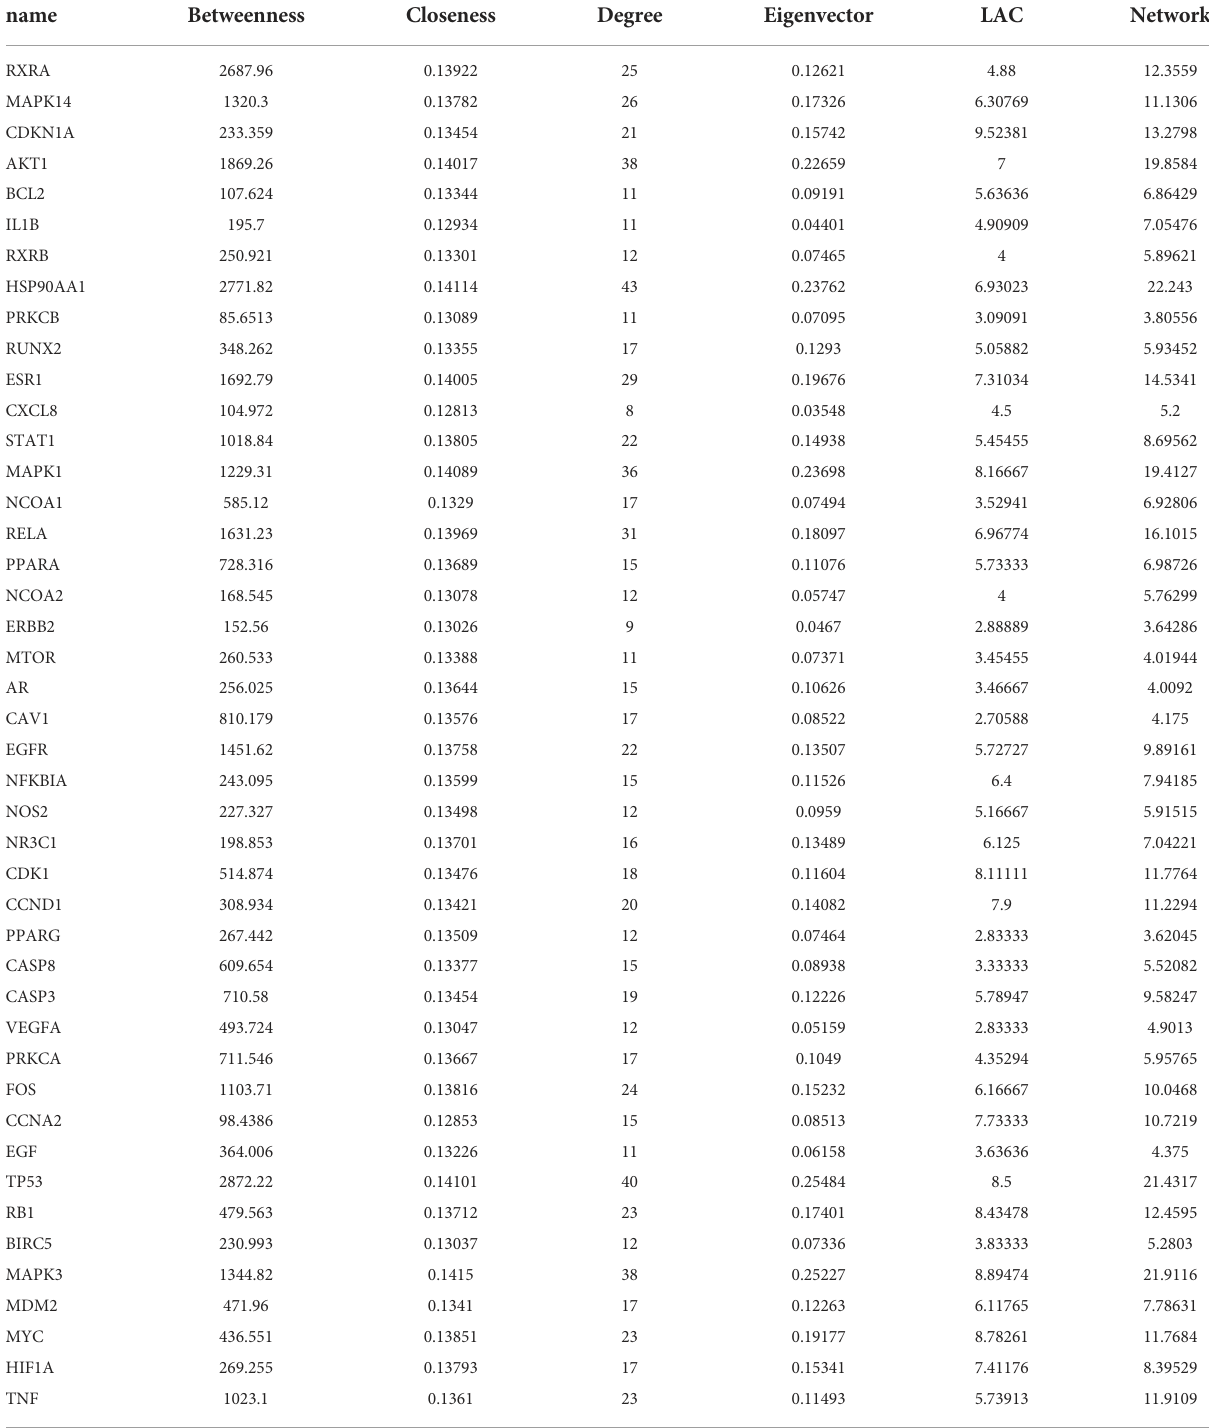
TABLE 3 Information on 44 core